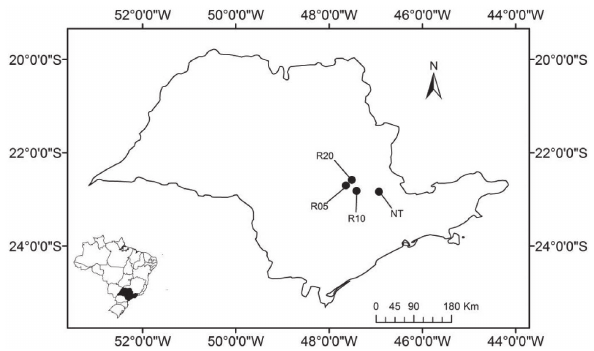
Figura 1. Mapa com a localização das quatro áreas de estudo: mata nativa (NT), e áreas em recuperação a 20 (R20), 10 (R10) e cinco (R05)